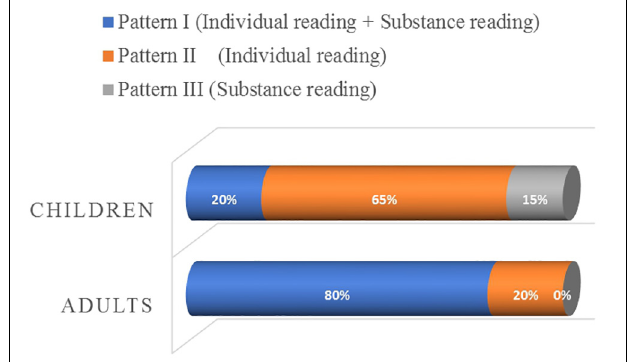
FIGURE 6 | Patterns of responses in the interpretation of the duo-shao sentences.